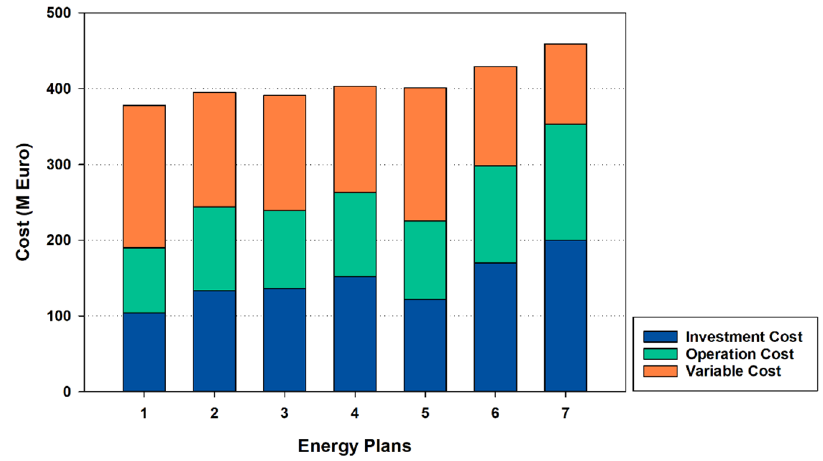
Figure 16. Total cost breakdown of seven energy plans for forecast year. Table 4. The results of energy modeling as the initial decision matrix.